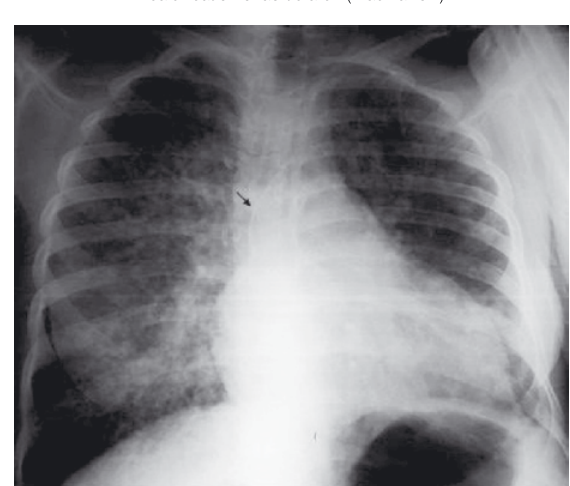
Figure 1. PA chest radiography. Reticular interstitial involvement pattern in both lungs, especially in the right and calcification of aortic arch (Black arrow).